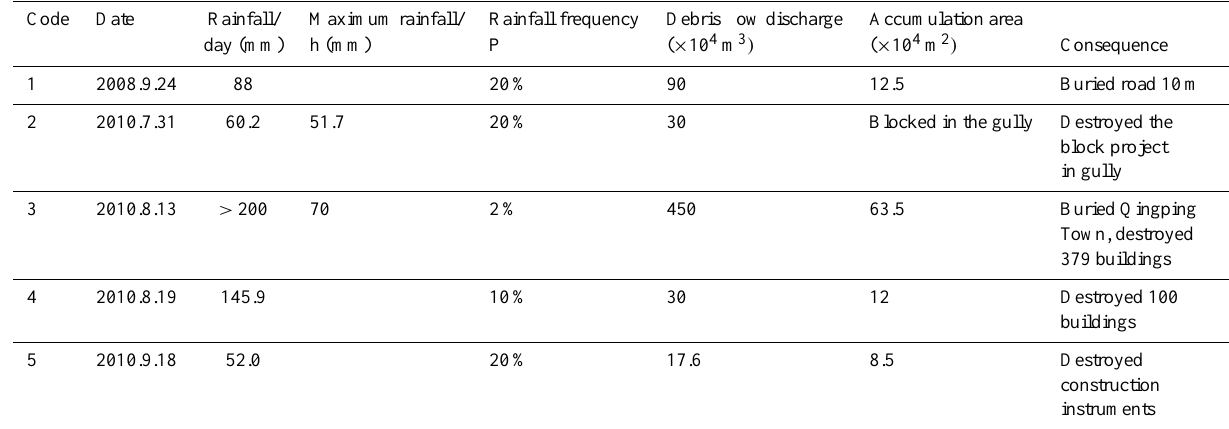
Table 2. Typical debris flows developed in the Wenjia gully after the 2008 Wenchuan Earthquake.